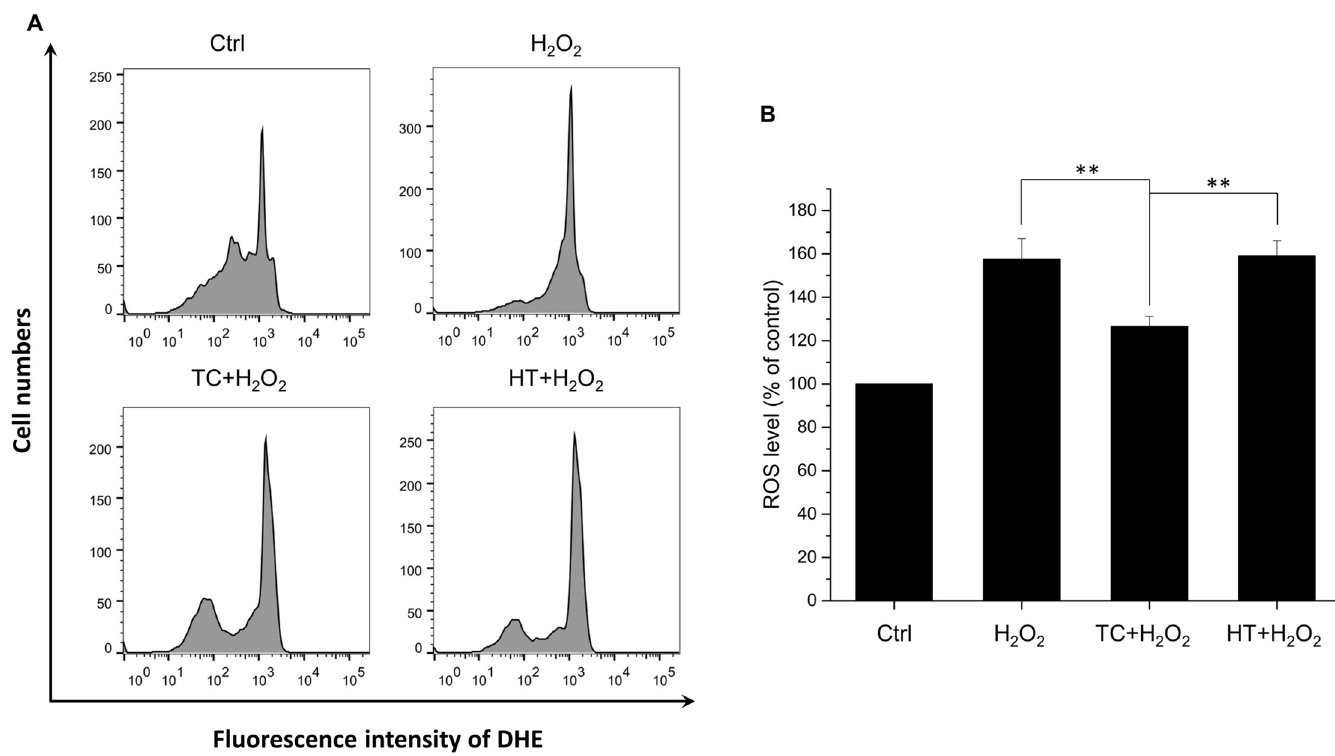
Fig 4. Effect of TC-HT on H 2 O 2 -induced ROS generation in SH-SY5Y cells. (A) ROS level was measured 24 h after the H 2 O 2 treatment by flow cytometry with DHE fluorescent dye. (B) Quantification of the ROS levels after H 2 O 2 , TC+H 2 O 2 , or HT+H 2 O 2 treatment. Data represent the mean ± standard deviation (n = 3). �� P < 0.01.